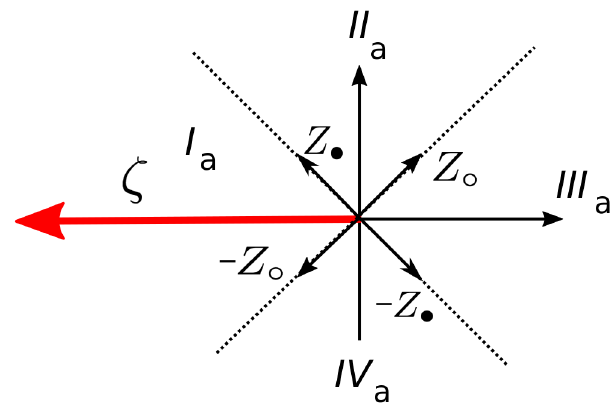
Figure 6 . The Z 4 point of su 2 at strong